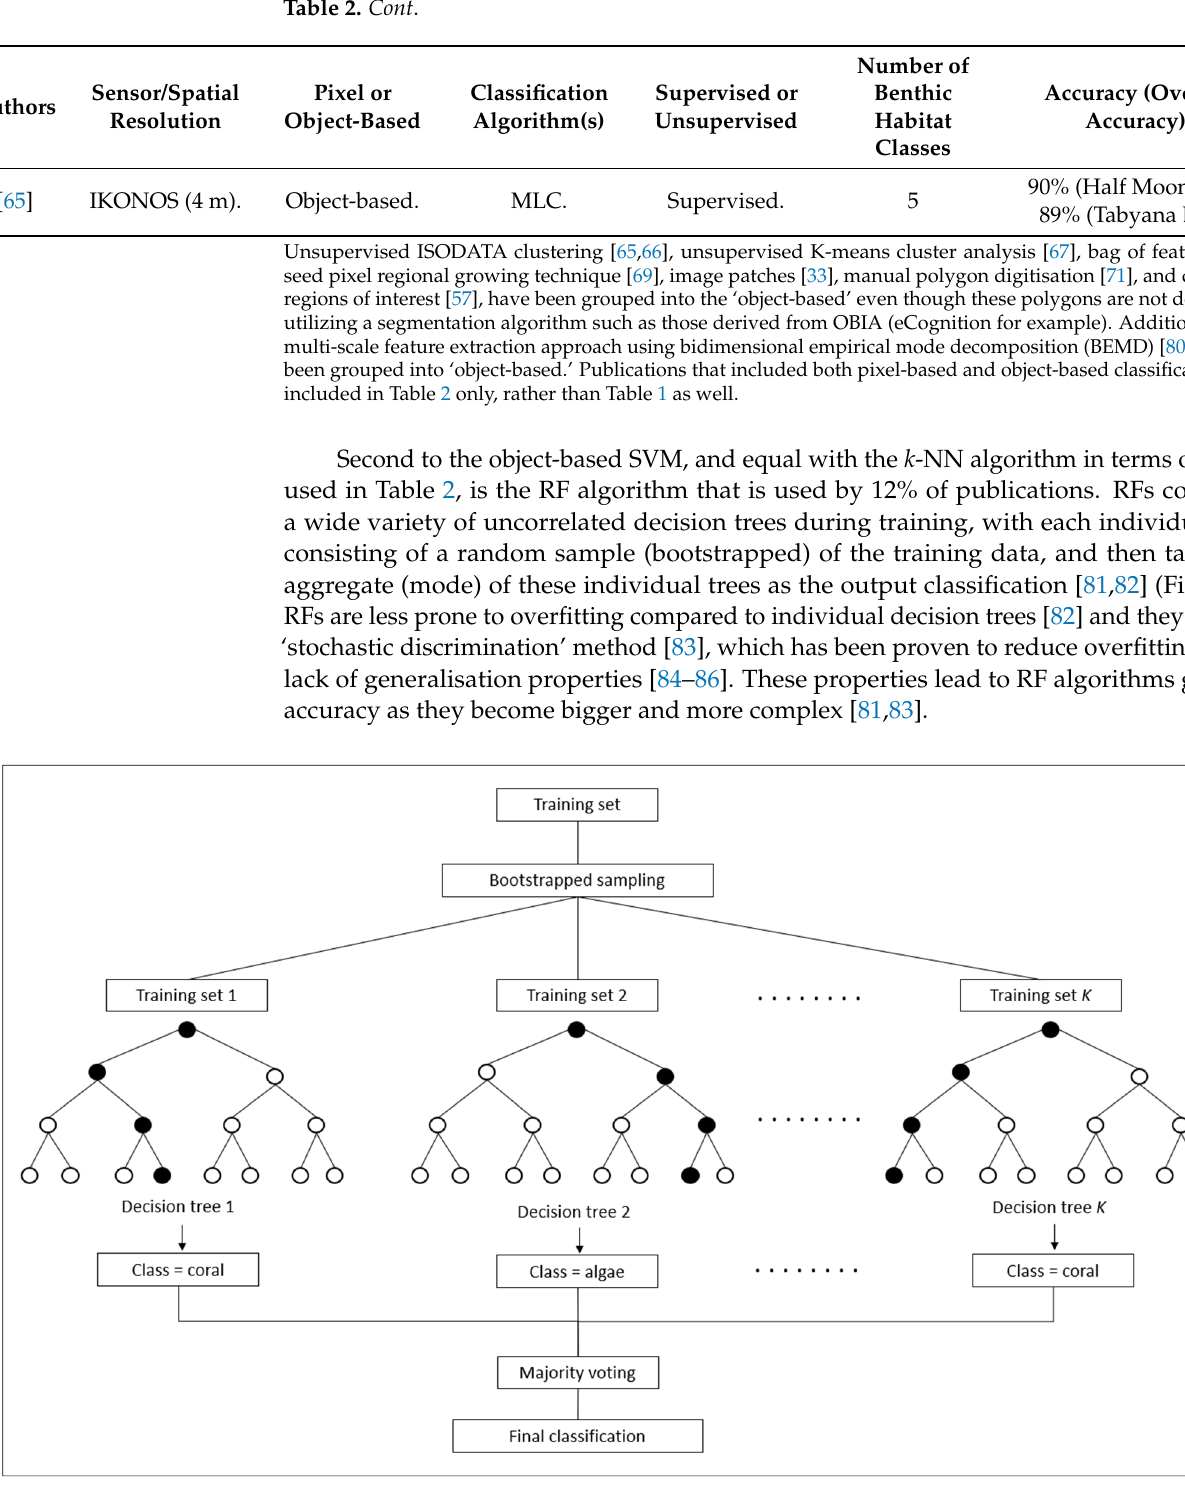
Figure 6. Basic conceptualization of random forest classification.